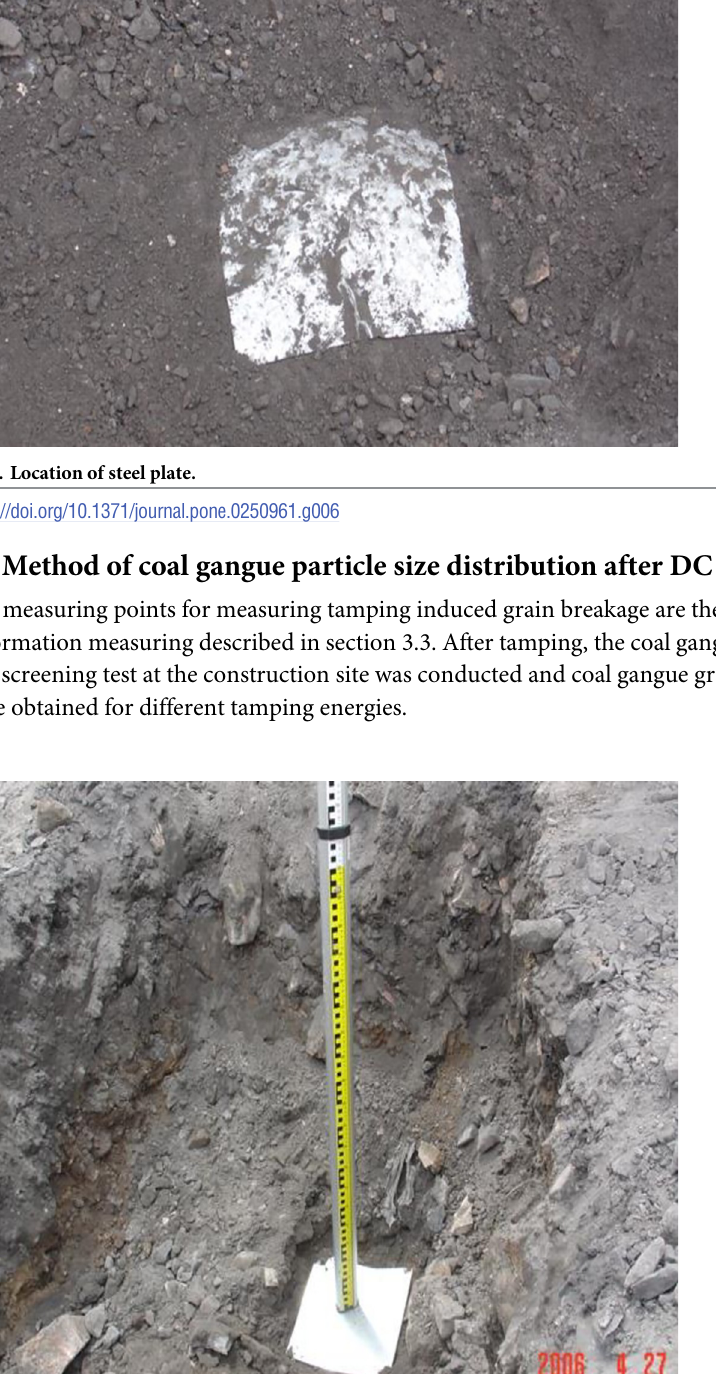
Fig 7. Measure the tamping